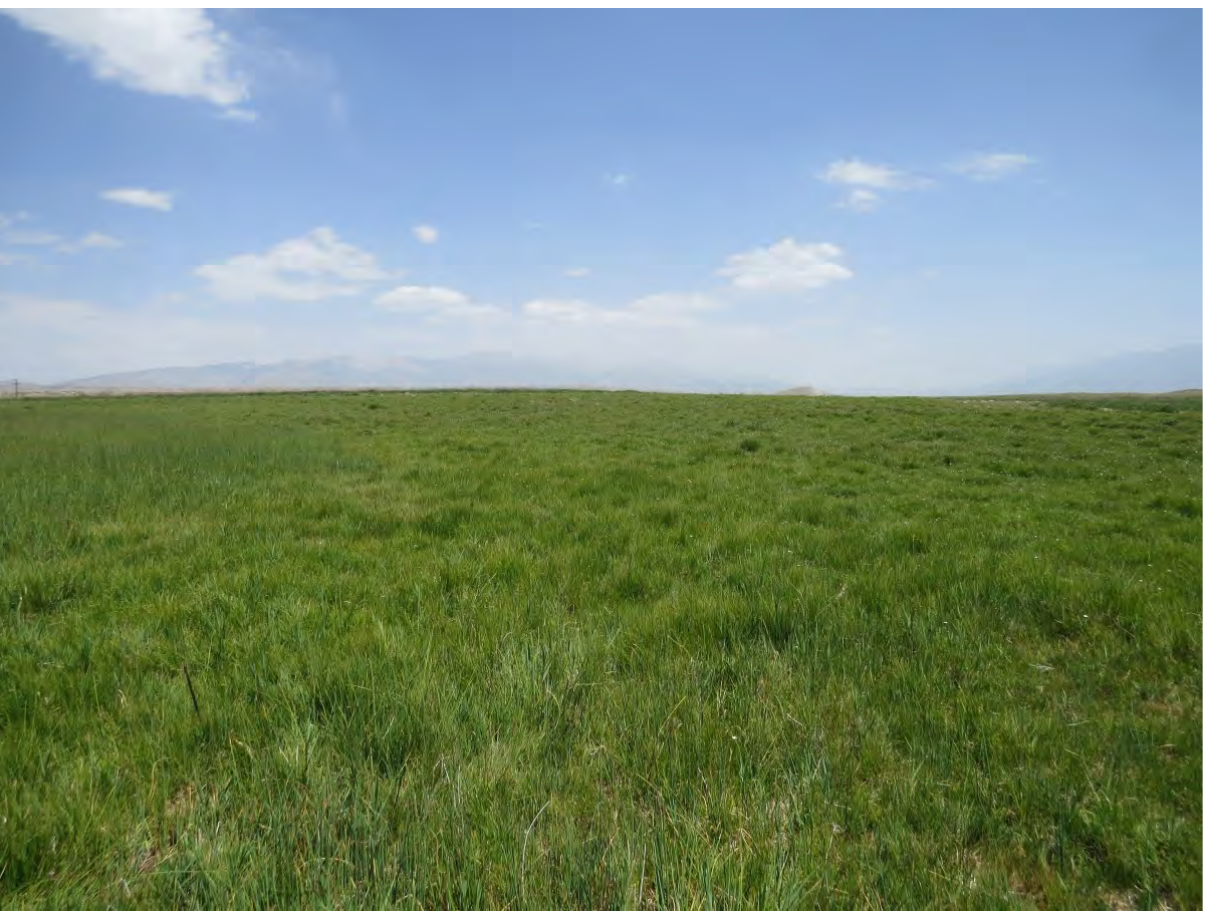
Figure 3. Photograph of the At-Bašy Peatland (photo Thomas